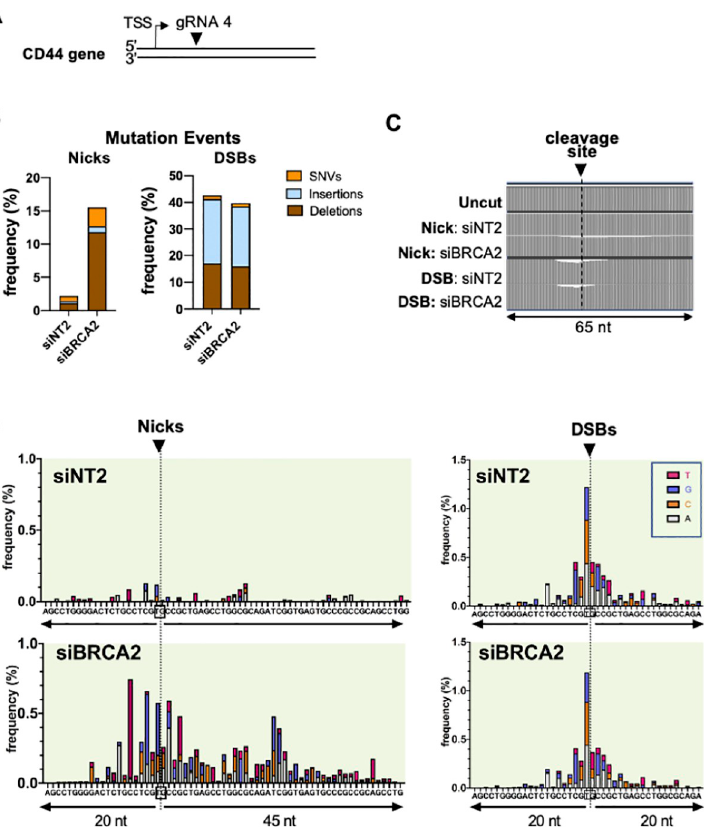
Fig 1. Depletion of BRCA2 increases the frequency of mutations at nicks. (A) Diagram of site targeted for cleavage in CD44 gene of human U2OS cells, showing transcription start site (TSS) and the site on the non-transcribed strand targeted for cleavage by gRNA 4 (arrowhead). (B) Frequencies of mutation events at nicks and DSBs targeted by gRNA 4, as determined by amplicon sequencing. Deletions, insertions and single nucleotide variations (SNVs) were scored in control cells (siNT2) or cells depleted for BRCA2. (C) Maps of the fractional decrease in the number of bases at each position within the indicated 65 nt region spanning the gRNA 4 cleavage site in U2OS cells. DNA was uncut, or targeted for nicks or DSBs, in control cells (siNT2) or cells depleted for BRCA2, as indicated. (D) Maps of positions and spectra of SNVs within the indicated regions spanning nicks or DSBs in U2OS cells treated with control siNT2 or siBRCA2. Arrowheads and dashed lines below them indicate the site of the nick or DSB, which targets the DNA backbone between the nucleotides boxed in the sequence below. The colored bar represents SNVs at each reference position: A, gray; C, orange; G, blue; T,